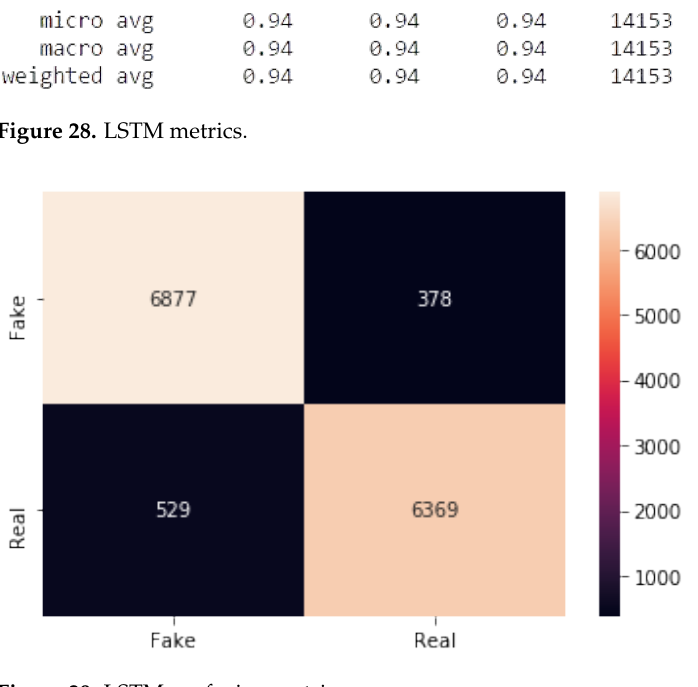
Figure 29. LSTM confusion